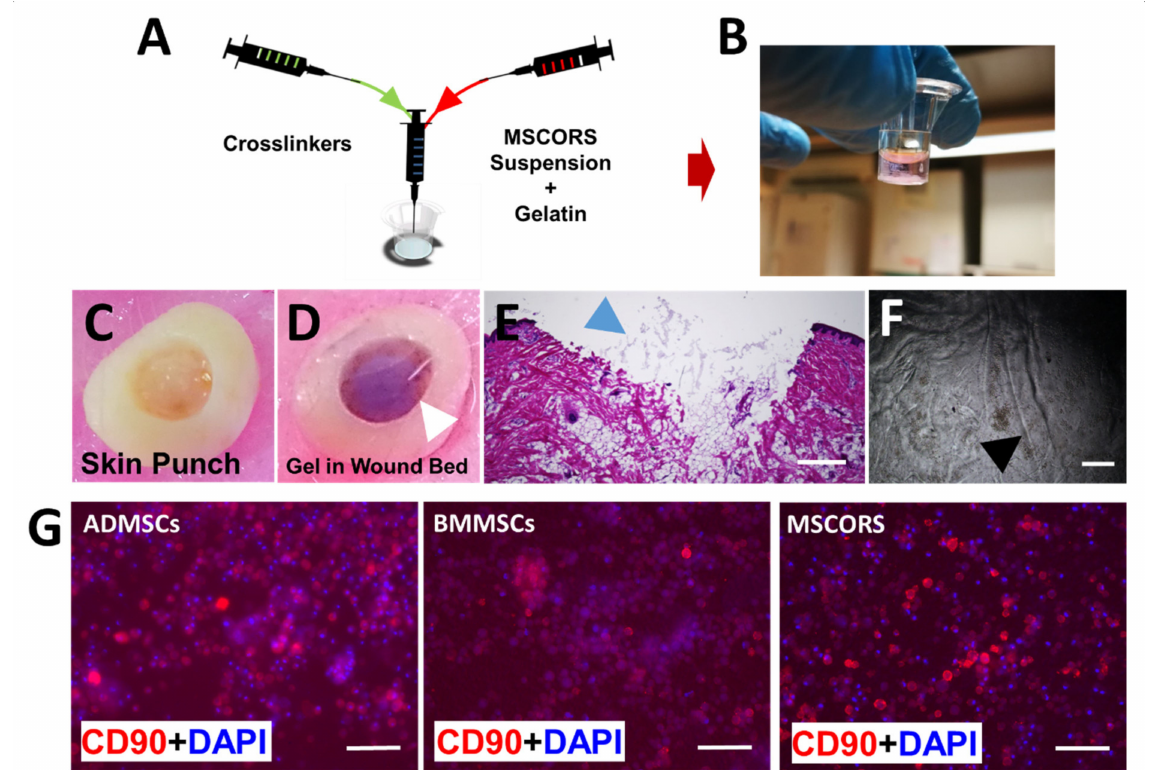
Figure 2. Osteogel production with MSCs encapsulation and semi-solid injectable Osteogel filling into an irregular wound bed of porcine skin model. ( A ) Production of cross-linked gelatin-based hydrogel and encapsulation of MSCs within the Osteogel. The cell suspension was first resuspended in a gelatin solution, and then co-injected together with the oligomer solution and triethanolamine (TEOA) base into a Transwell mold and mixed well. Gel formation was achieved by injecting the three components through an automatic pipette. The gelation process took place instantly and allowed for concomitant MSC encapsulation. ( B ) Osteogel in a Transwell mold. ( C ) Full-thickness punch lesion of a porcine skin was produced using a 5 mm biopsy punch. ( D ) Osteogel filled into the wound bed (white arrow). ( E ) H&E staining of the wound bed filled with the Osteogel (blue arrow), fitting completely the irregularly shaped lesion. ( F ) Crinkles pattern in the solidified hydrogel produced during stirring (black arrow). ( G ) Immunostaining of CD90 in ADMSCs, BMMSCs, and MSCORS grown for 7 days within the Osteogel. All MSCs displayed an intense CD90 cell surface signal, with MSCORS and ADMSCs being the most intense. Scale bar: € 500 µ m, ( F ) 250 µ m, ( G ) 50 µ m; Magnificatio € ( E ) 2 × , ( F ) 4 × , ( G ) 20 ×